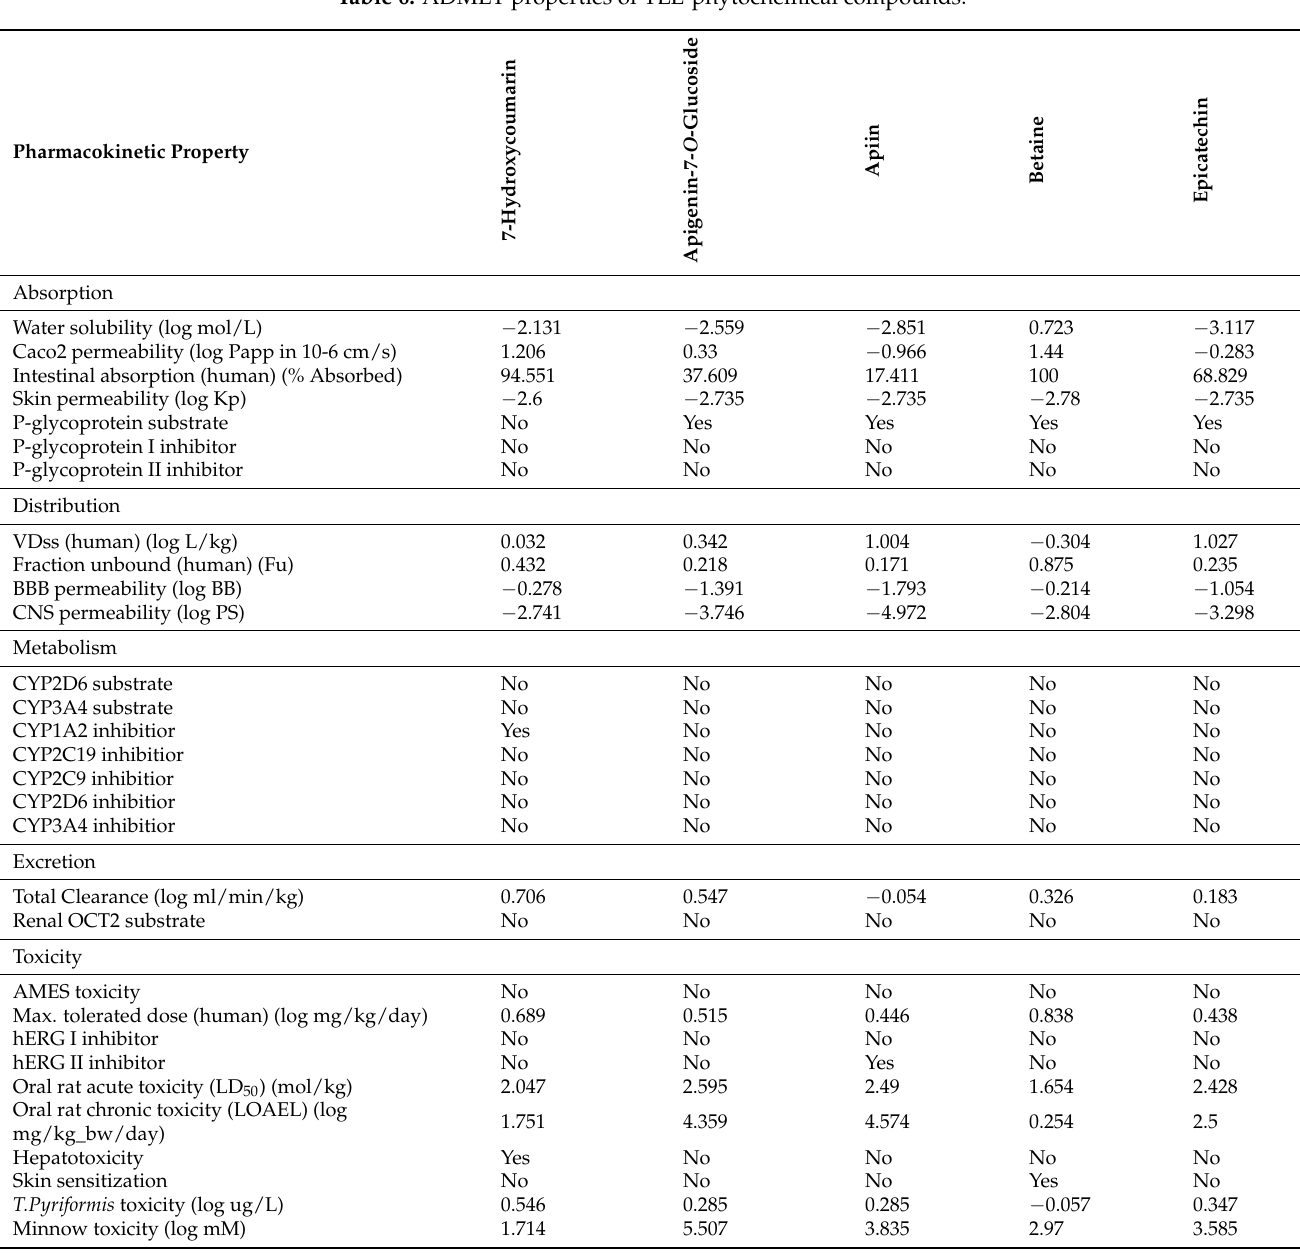
Table 6. ADMET properties of TLE-phytochemical